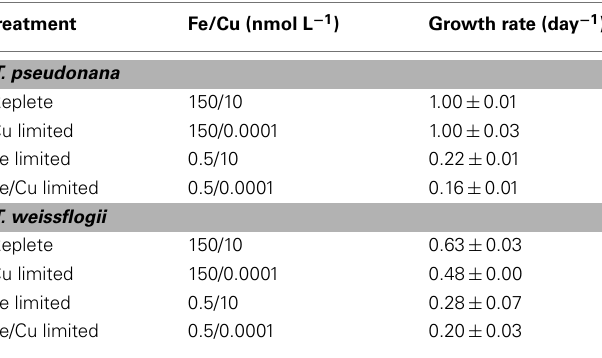
Table 3 | Culture conditions and growth rates of T. pseudonana and T. weissflogii .